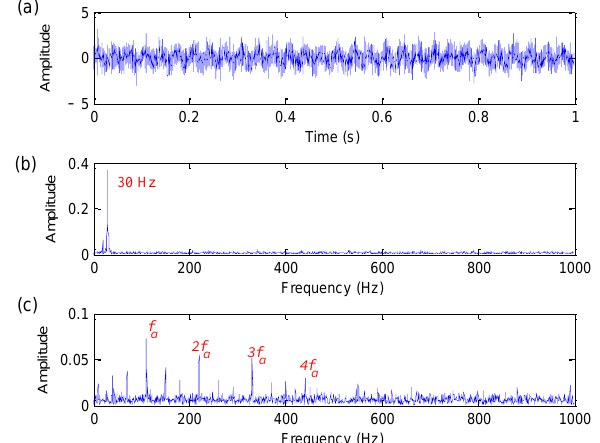
Figure 8. Analysis results obtained by EMDF method for simulation signal: ( a ) Time domain waveform; ( b ) amplitude spectrum; ( c ) envelope spectrum.